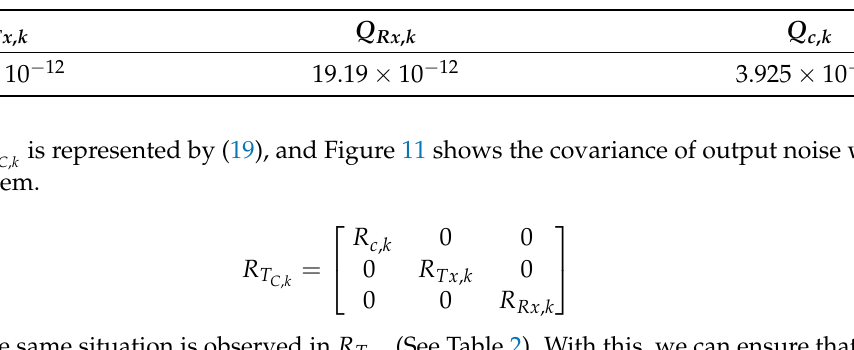
Table 2. Temporary covariance values of the output noises R T